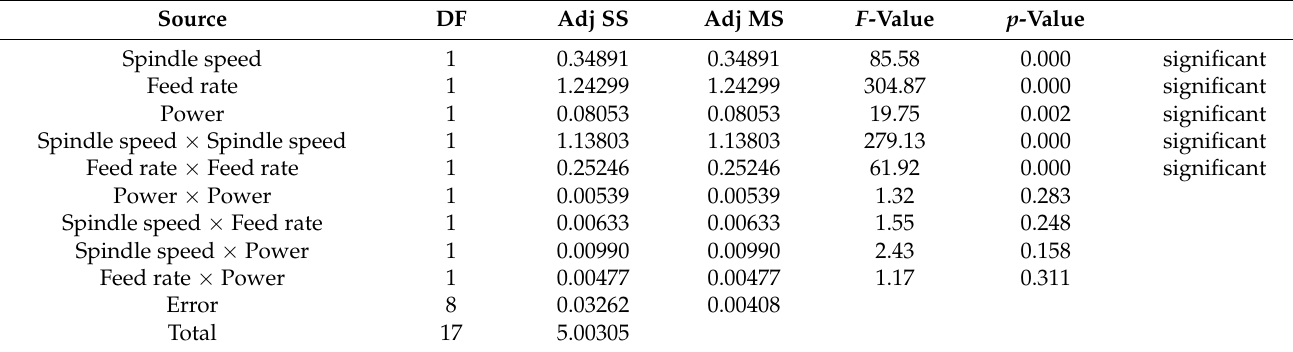
Table 10. ANOVA results for the flank wear width with water-soluble sago starch cutting fluid.